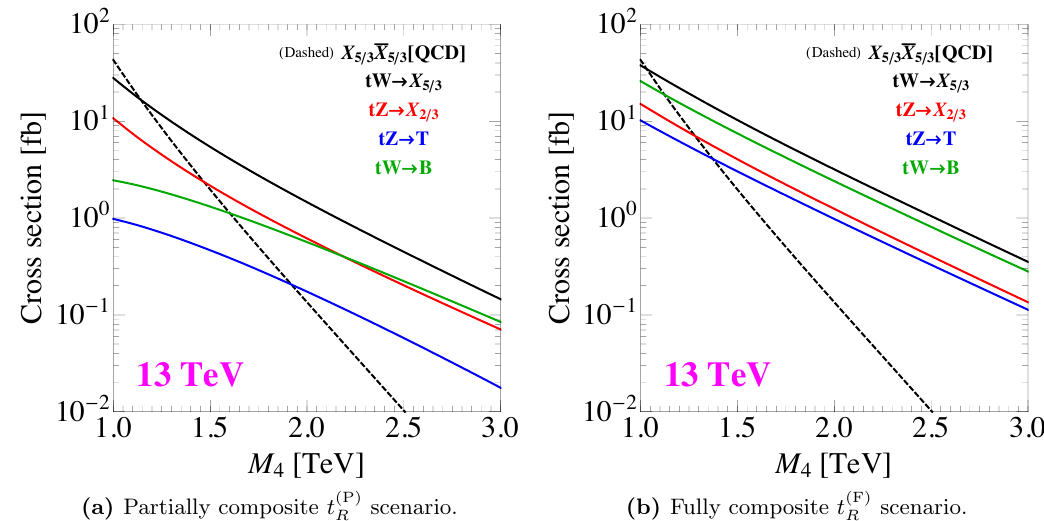
Figure 2. The production cross sections of quartet top partners at the 13 TeV LHC. The pa- rameters are chosen as f = 1 TeV, y L = 1 and c 2 = 1 (for fully composite t (F) partially composite t (P) models and y 2 L in fully composite t (F) R quark mass M t = 150 GeV (see eq. (B.18) and eq.